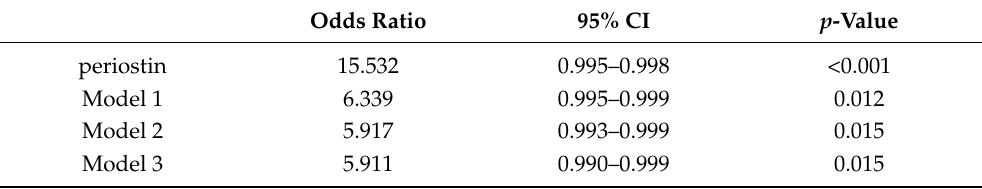
Table 3. Binary logistic regression analysis of predictors for admission ASPECT score < 6 in patients with acute ischemic stroke.CI, confidence interval. Model 1 included Glasgow Coma Scale and National Institute of Health Stroke Scale. Model 2 included variables in model 1 plus atrial fibrillation and admission level of C-reactive protein. Model 3 included variables in model 2 plus diabetes, admission serum level of creatinine and admission neutrophil-lymphocyte